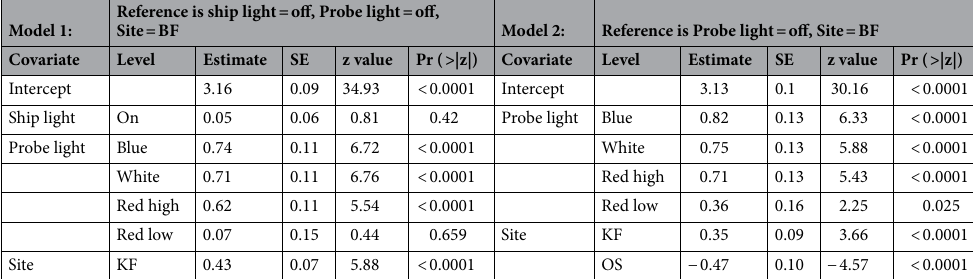
Table 1. Fixed-effect coefficient estimates of the generalized linear mixed-models of light avoidance. BF Billefjorden, KF Kongsfjorden, and OS